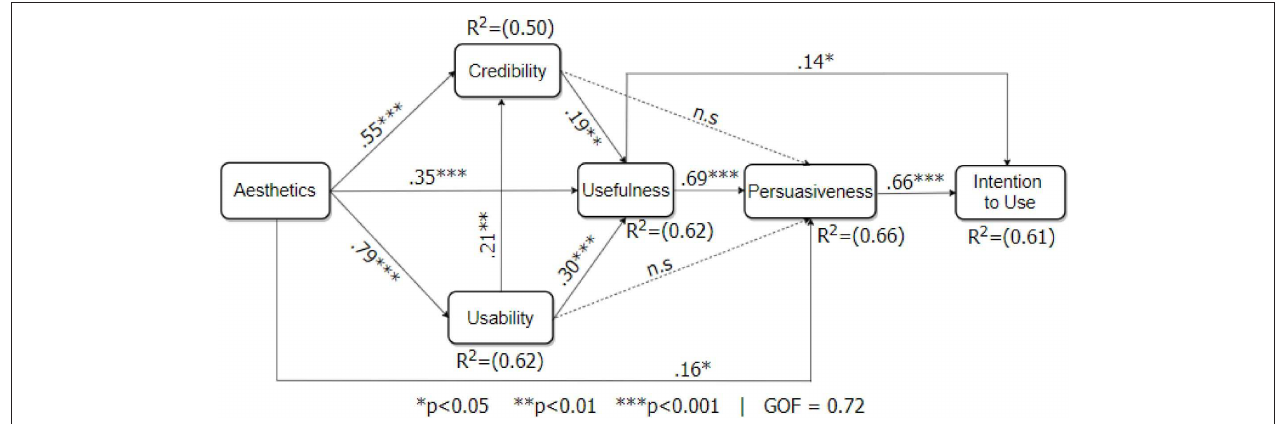
FIGURE 5 | Individualist persuasive technology acceptance model (for brevity, we have omitted the representation of the non-significant relationships between credibility/usability and intention to use).